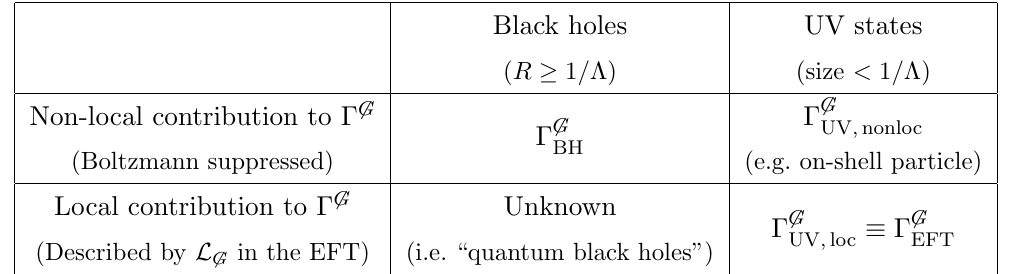
Table 1 . Rates of global symmetry violation at sub-Planckian temperature T < (cid:3) ex- pected from the quantum gravity theory. From general considerations it is expected